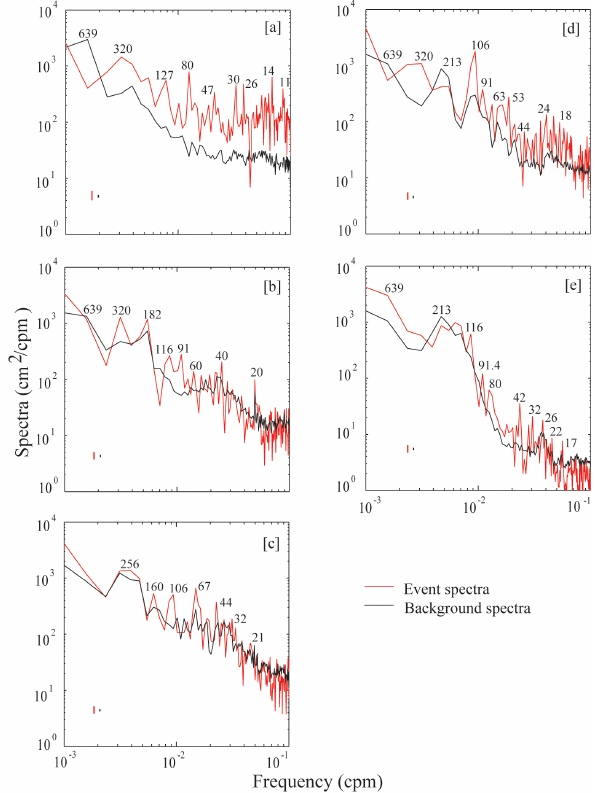
Figure 10. Spectrum of sea level residual (SLR) during E1 at (a) Ratnagiri, (b) Verem, (c) Karwar, (d) Tuticorin and (e) Man- dapam. The data duration for estimating the spectrum of the SLR during E1 (background) is from 26 November to 1 December (1 September to 20 November) 2011. Vertical red (black) line shows the 95% confidence interval of the event (background) spectrum for the respective